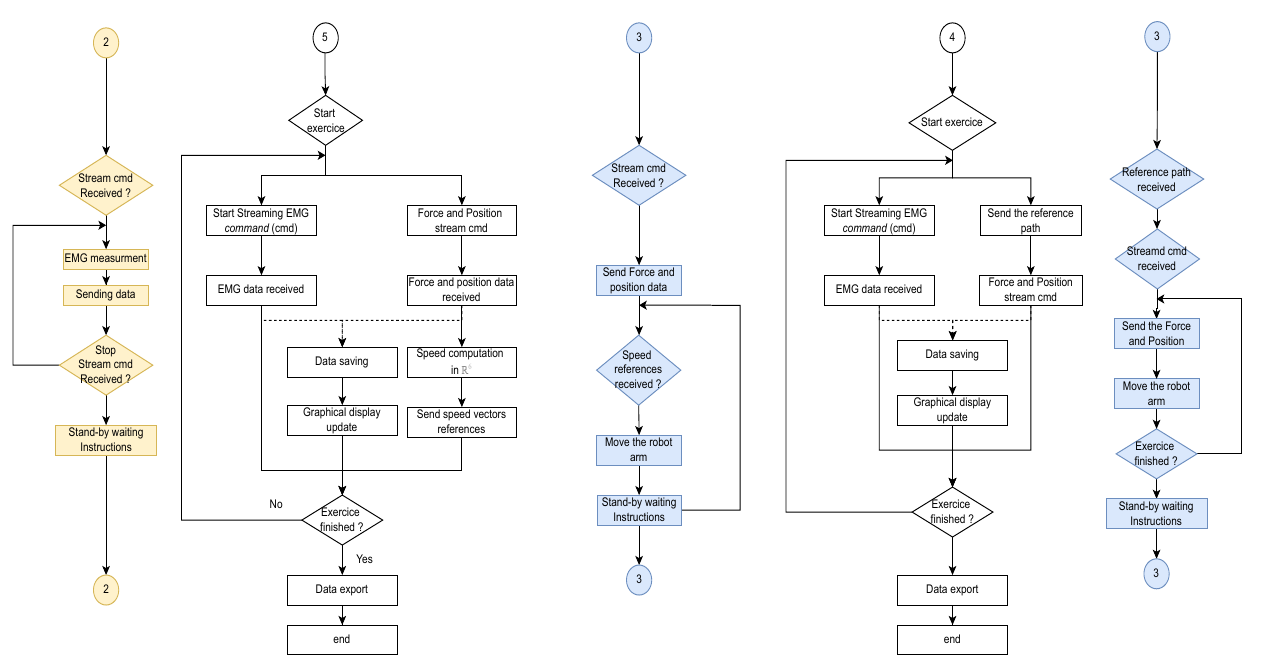
Figure 4. Operation flowchart for the remote control system, part 2. White color defines the flowchart in the software. Blue color defines the flowchart in the robot. Yellow color defines the flowchart in the shimmer sensor.